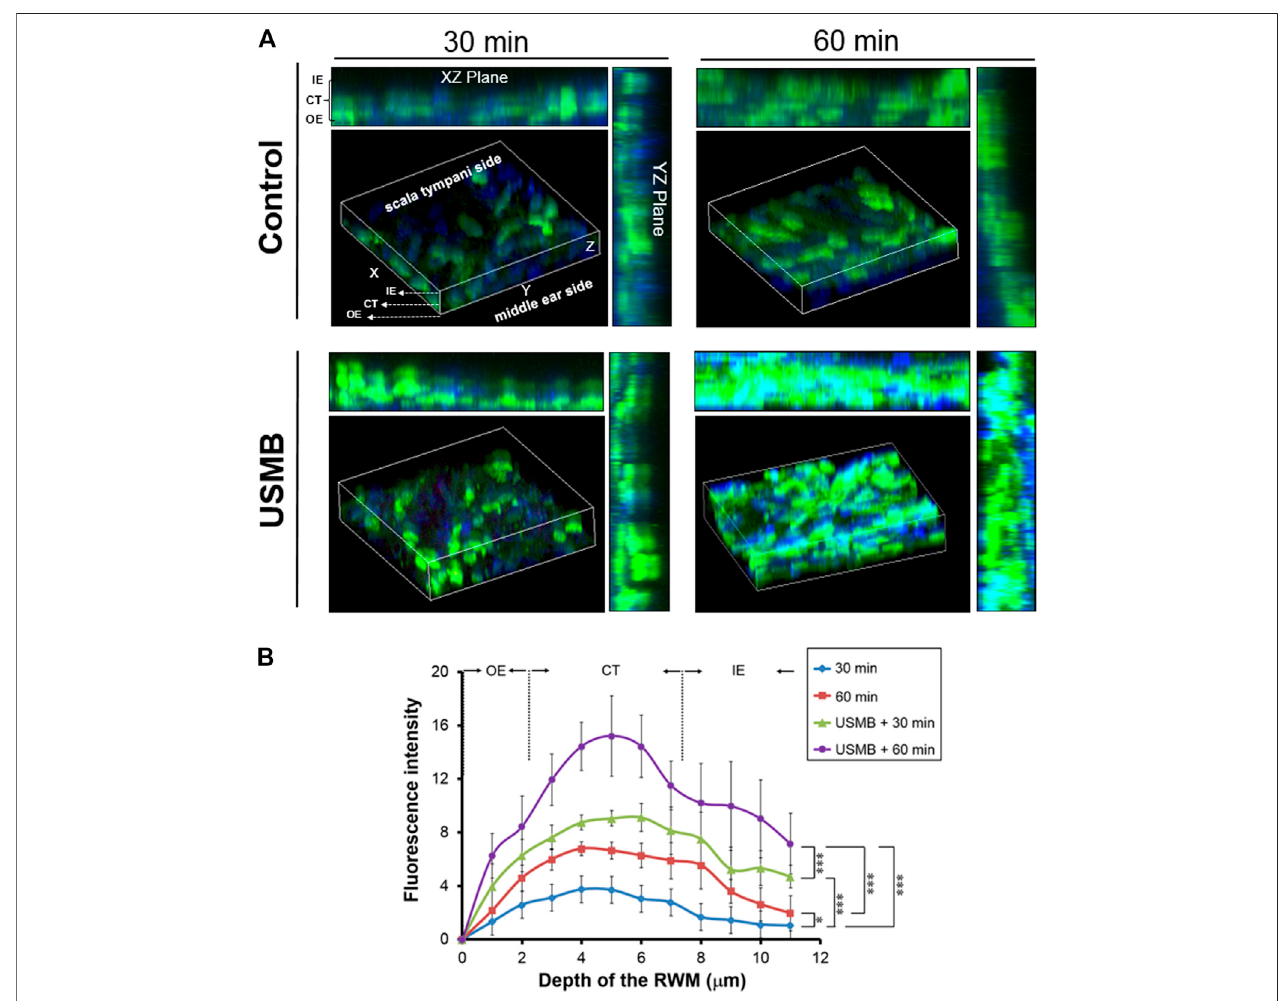
FIGURE 8 | Series of confocal laser scanning microscope images of the RWM after FITC-CS-AuNP treatment with or without prior USMB exposure. (A) Three- dimensional reconstruction of the RWM by z-stack imaging was used to assess penetration of fl uorescent FITC-CS-AuNPs through the three-layer membrane after treatment for 30 and 60 min. Control group (cid:2) mouse tympanic bulla soaked with FITC-CS-AuNPs for 30 and 60 min. USMB group (cid:2) mouse tympanic bulla exposed to USMB fi rst, followed by soaking with FITC-CS-AuNPs for 30 and 60 min. (B) Quantitative analysis of the fl uorescence intensity of z-stacking images. Values are expressed asmean ± standarderrorofthemean( n (cid:2) 5).RWM,round windowmembrane;USMB, ultrasoundmicrobubble. * p < 0.05,** p < 0.01,*** p < 0.001(one-way ANOVA, with post hoc Bonferroni